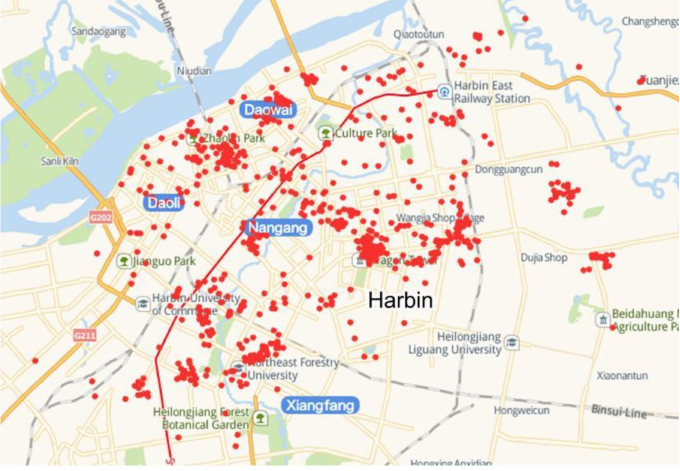
Figure 2. The location of selected